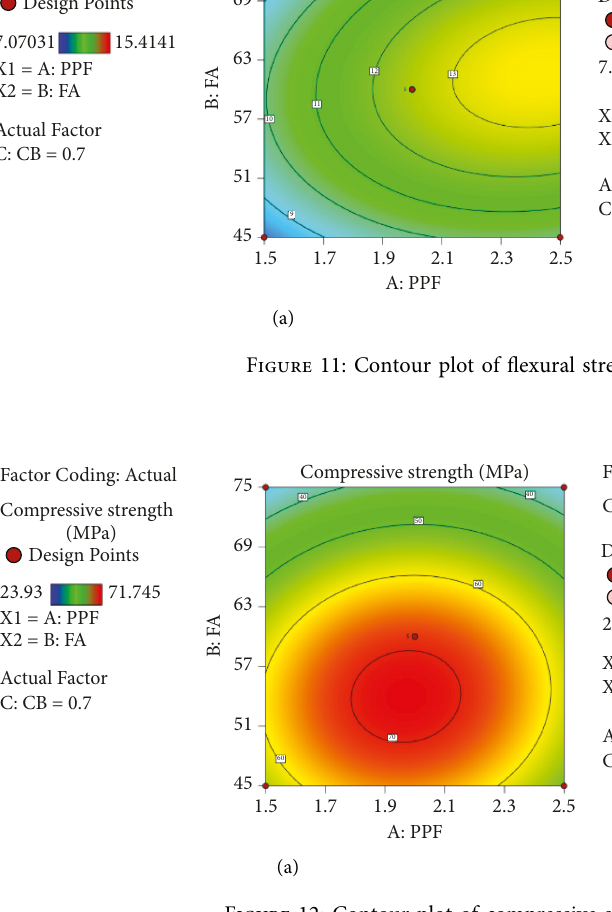
Figure 12: Contour plot of compressive strength. (a) R2. (b) 3D graph of R2.